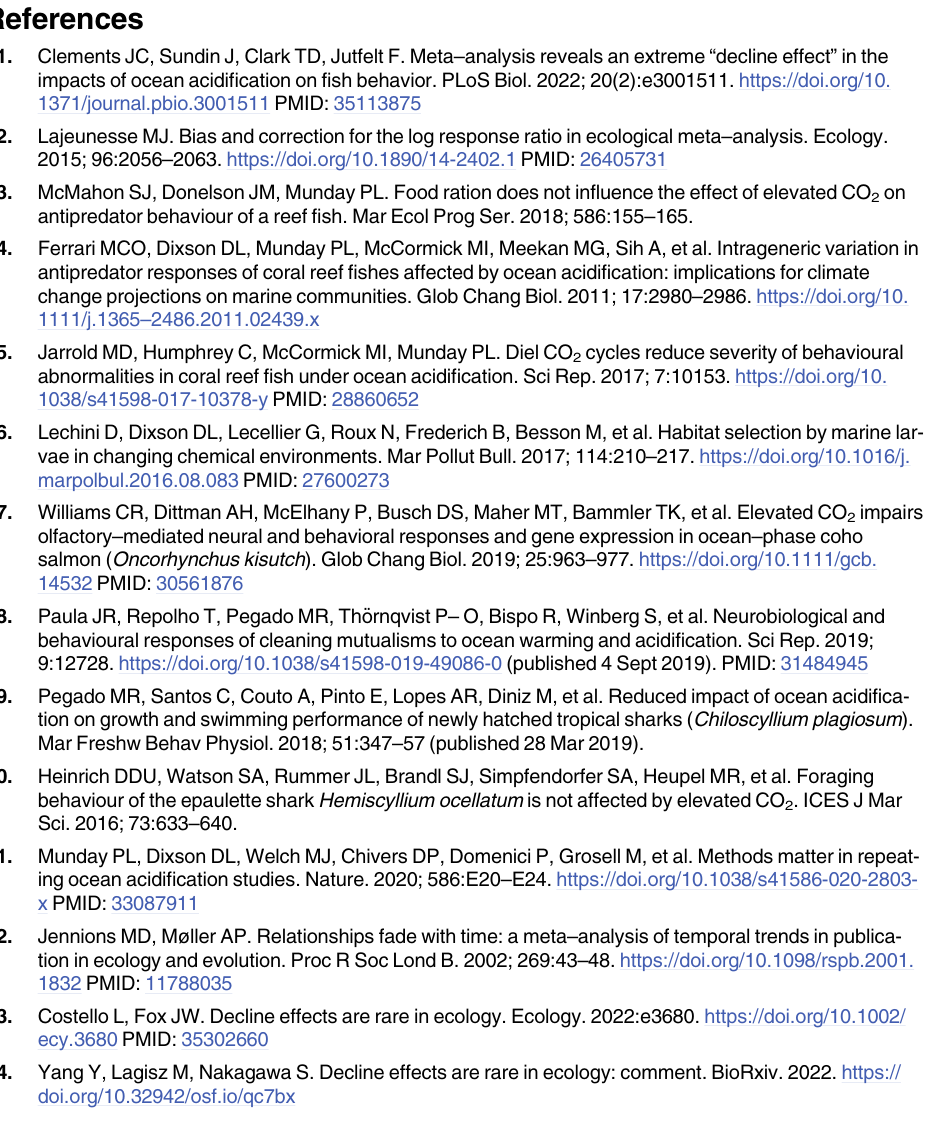
Table A. Data errors identified in a non–exhaustive preliminary check of Clements and col- leagues’ S2 data file, along with incorrect inclusion of sham treatments, missing data, and exclu- sions that were corrected to enable analysis. Highlight refers to the colour used to show the relevant lines of data in the screened, corrected, and complete data file used in the reanalysis.